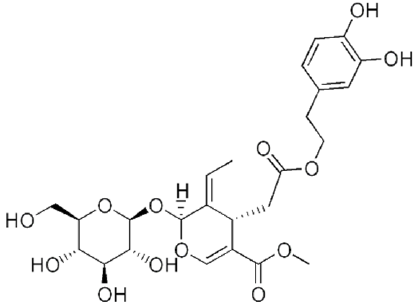
Figure 3. The chemical structure of oleuropein.